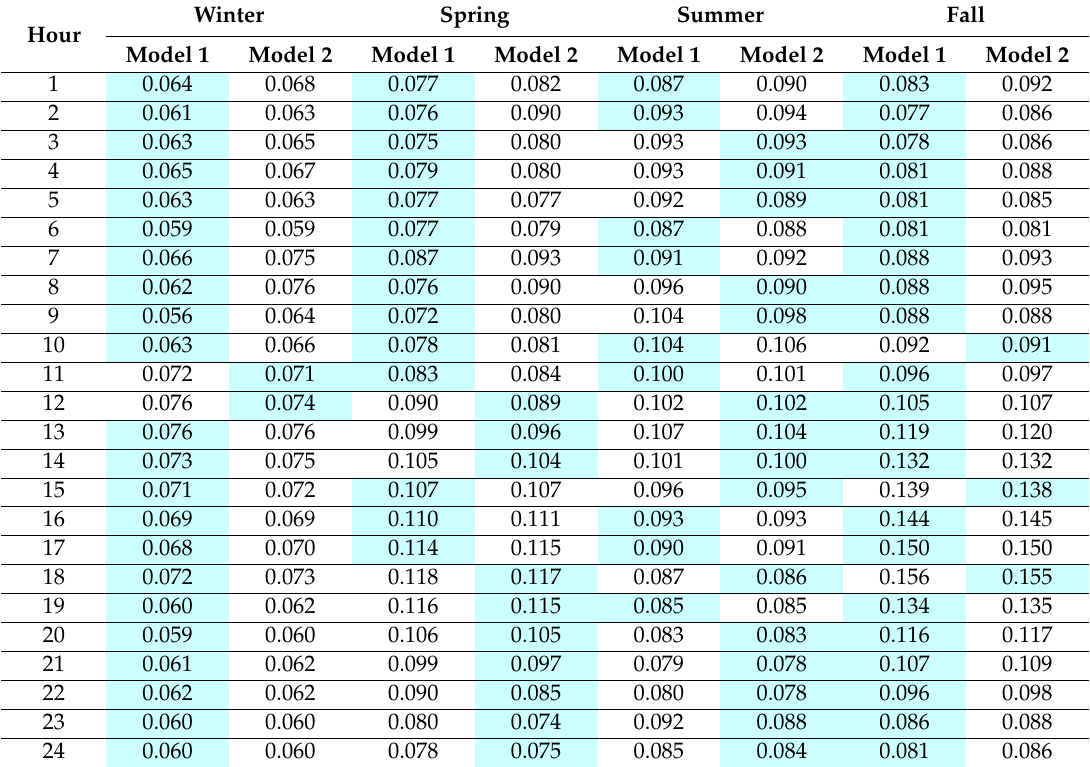
Table 3. The comparison between the CV of the two models for each season by